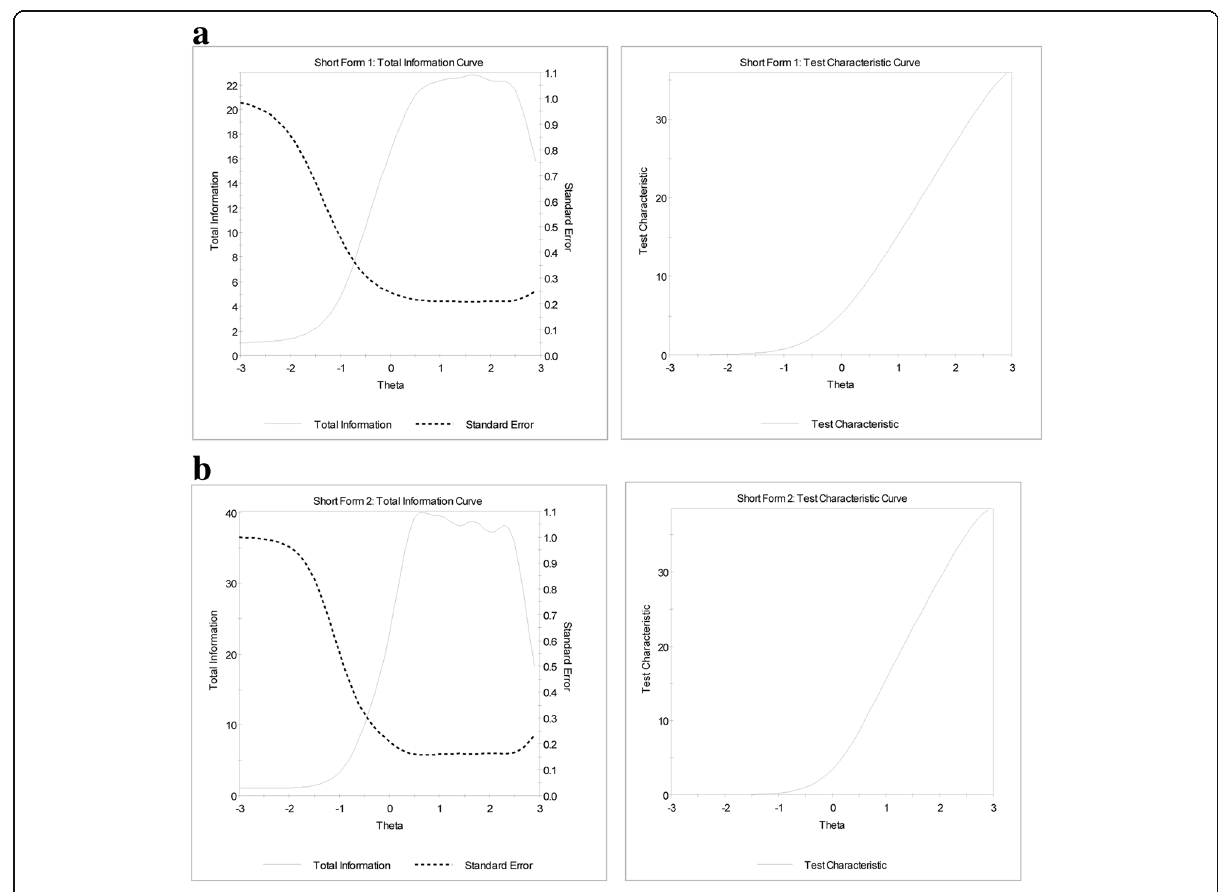
Fig. 5 Comparing test information curves for short forms 1 and 2. a Short Form 1 b Short Form